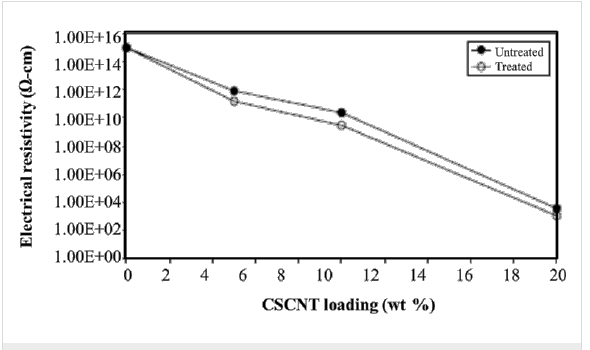
Figure 18: Effect of CSCNT loading on electrical resistivity. Repro- duced with permission from [141], copyright 2009 Elsevier.